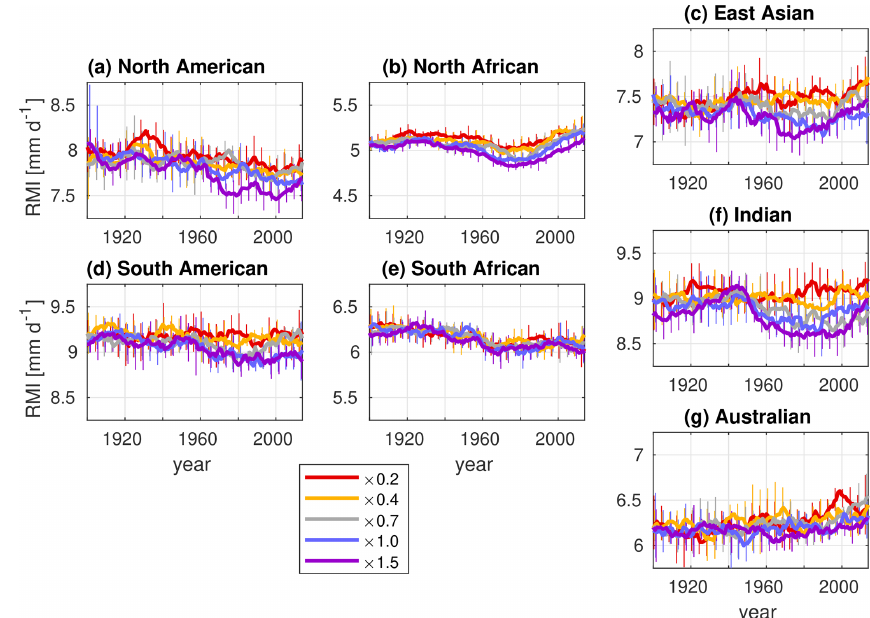
Figure 7. As Fig. 6, but for regional monsoon intensity (RMI), defined as the total rainfall within the RMA divided by the area of the RMA.